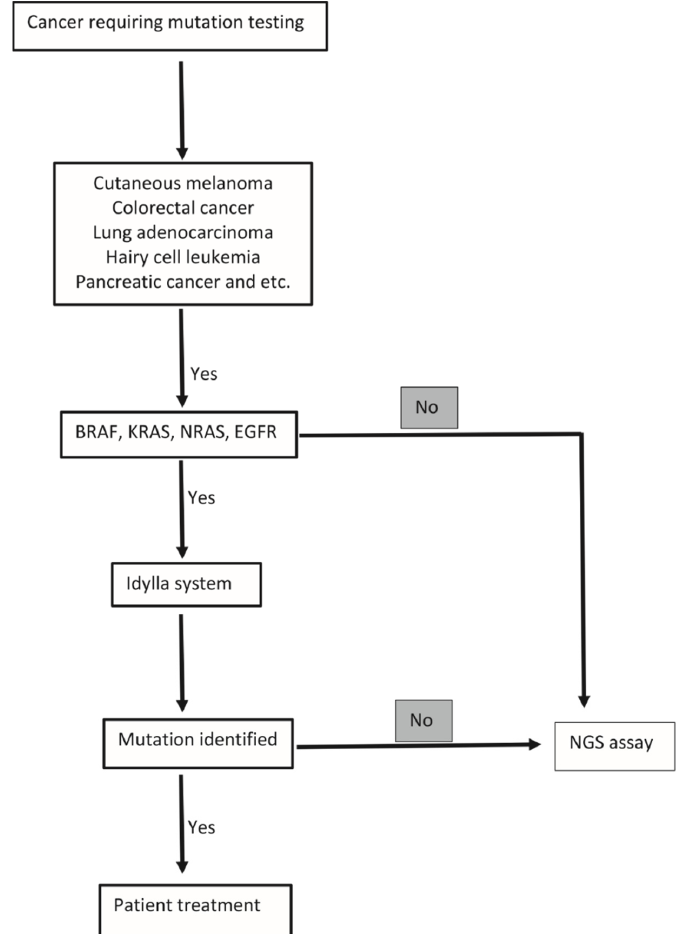
Figure 2. Generic algorithm for the clinical use of the Idylla platform .